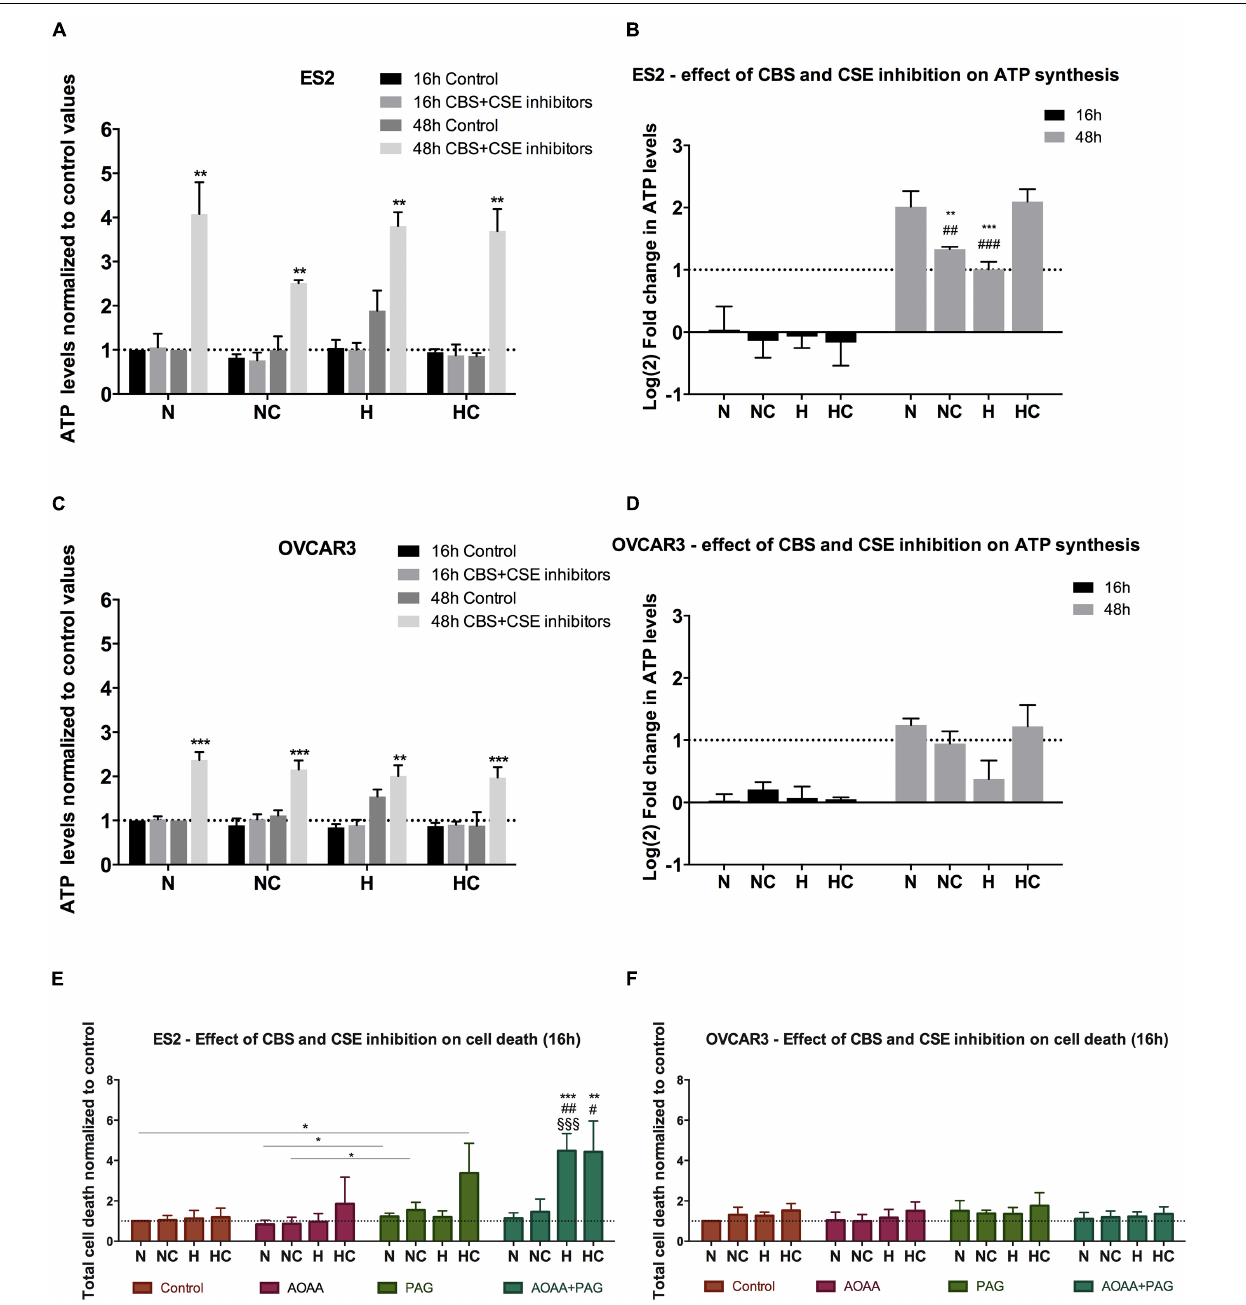
FIGURE 2 | CBS and CSE inhibition does not impair ATP synthesis in ovarian cancer cells but affect ES2 cells survival, mainly in hypoxia-mimicked conditions. (A–D) ATP levels in the presence of 1 mM AOOA and 3 mM PAG for 16 h and 48 h of experimental conditions for ES2 [ A – values normalized to control (normoxia without cysteine and without inhibitors) and (B) – values normalized to the respective control and log 2 fold change calculation] and OVCAR3 [ C – values normalized to control (normoxia without cysteine and without inhibitors) and (D) – values normalized to the respective control and log 2 fold change calculation] cells. (A,C) The asterisks (*) represent the statistical significance compared to the respective control. (B,D) The asterisks (*) represent the statistical significance compared to N, the section symbols (§) represents the statistical significance compared to NC and the cardinals (#) represent statistical significance compared to HC. For ES2, n = 6 for all treatments for 16 h of experimental conditions and n = 3 for 48 h of experimental conditions. For OVCAR3, n = 6 for all experimental conditions. (E,F) Cell death levels in the control condition, in the presence of CBS/CSE inhibitor (1 mM AOAA), CSE inhibitor (3 mM PAG) or both inhibitors for ES2 (E) and OVCAR3 (F) cells. The asterisks (*) represent statistical significance between the respective treatments or between AOAA + PAG and its control, the cardinals (#) represent statistical significance between AOAA + PAG and AOAA alone and the section symbols (§) represent statistical significance between AOAA + PAG and PAG alone. For both cell lines, at least n = 6 were performed for all experimental conditions. N, normoxia; NC, normoxia with cysteine; H, hypoxia; HC, hypoxia with cysteine. Results are shown as mean ± SD. * p < 0.05, ** p < 0.01, *** p < 0.001 [ (A,C) independent-samples t -test; (B,D–F) one-way ANOVA with post hoc Tukey tests].